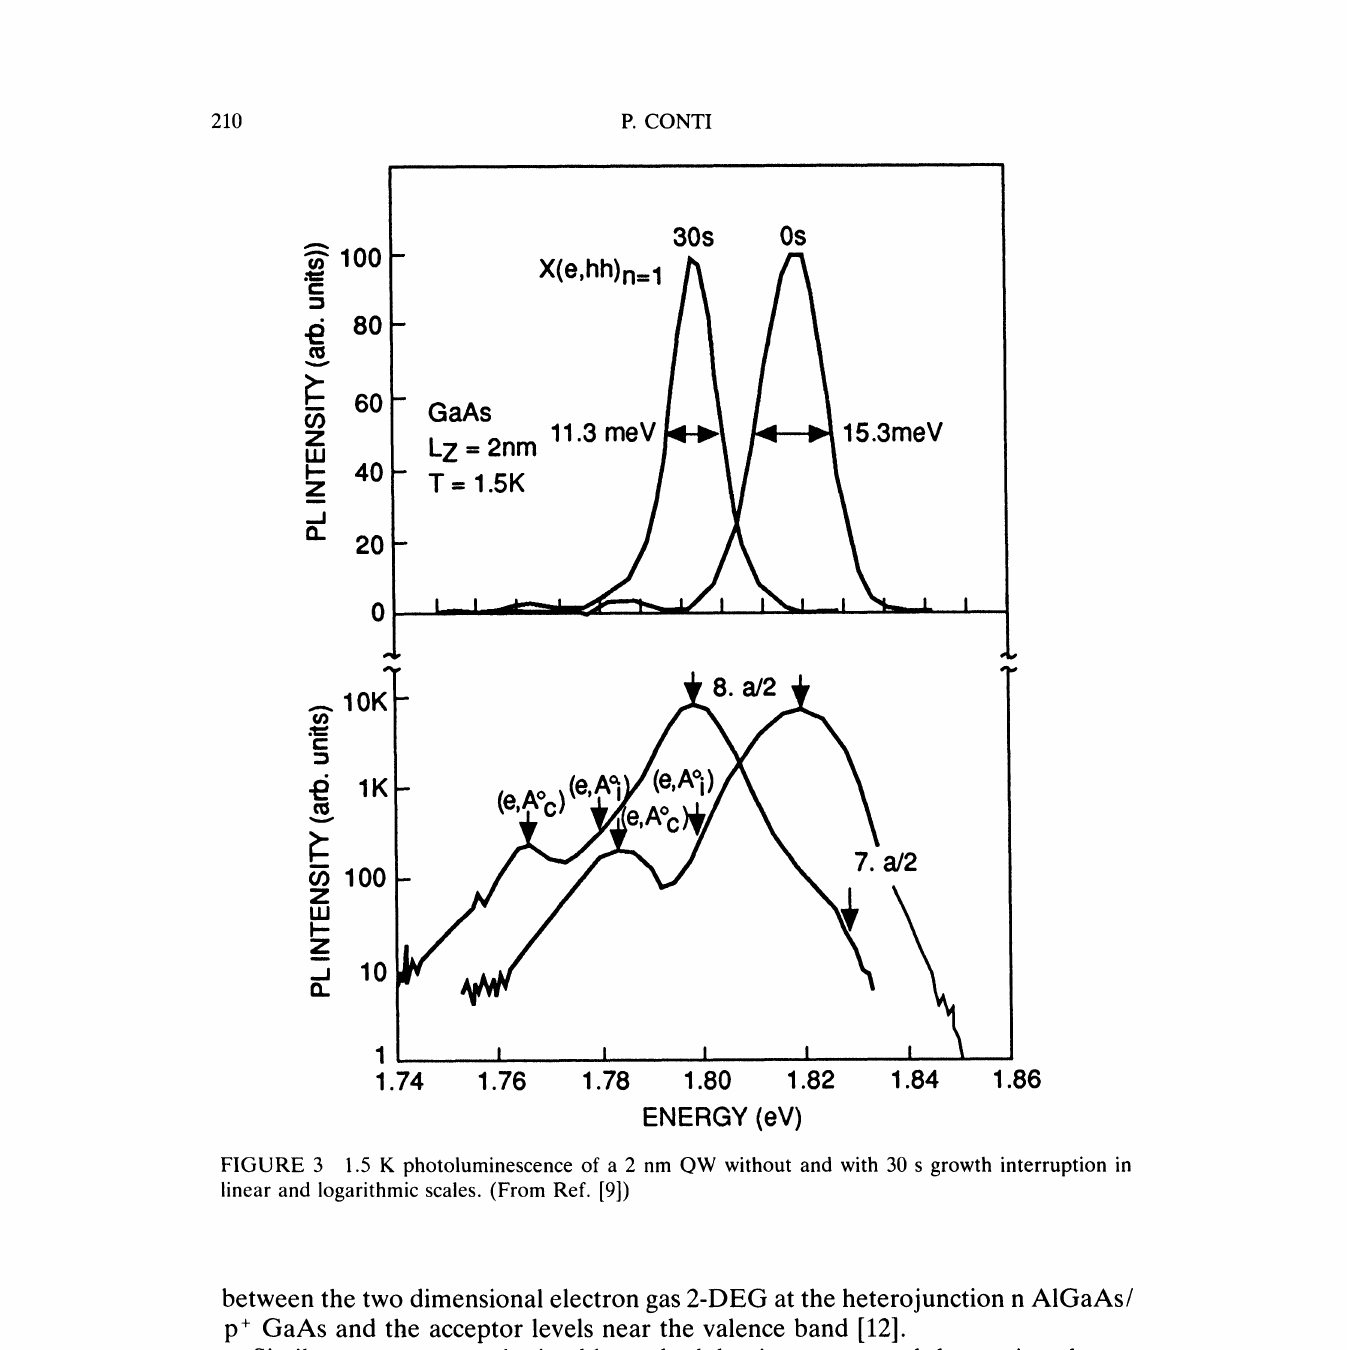
FIGURE 3 1.5 K photoluminescence of a 2 nm OW without and with 30 growth interruption in linear and logarithmic scales. (From Ref.